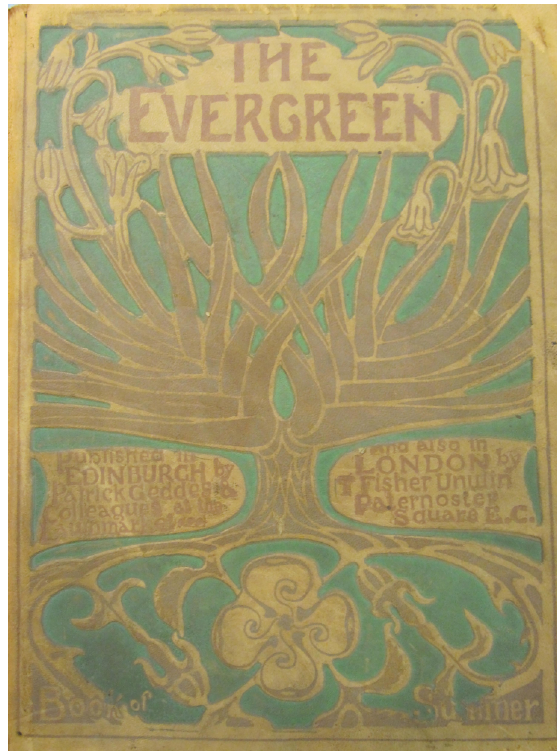
Fig. 1c Evergreen: A Northern Seasonal (Summer 1896), front cover, private collection.